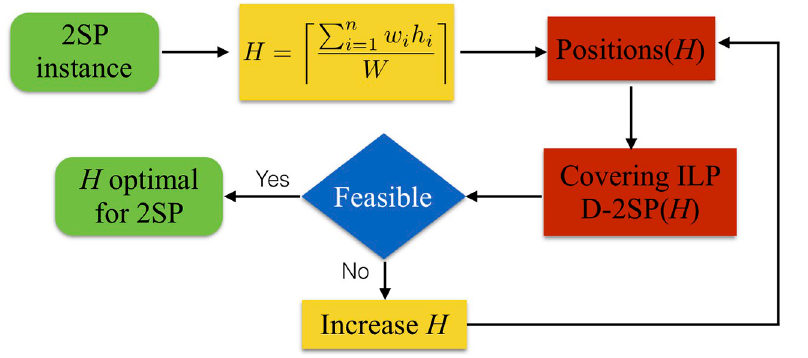
Fig 2. Adaptation of the P&C methodology. The two-step methodology to solve the